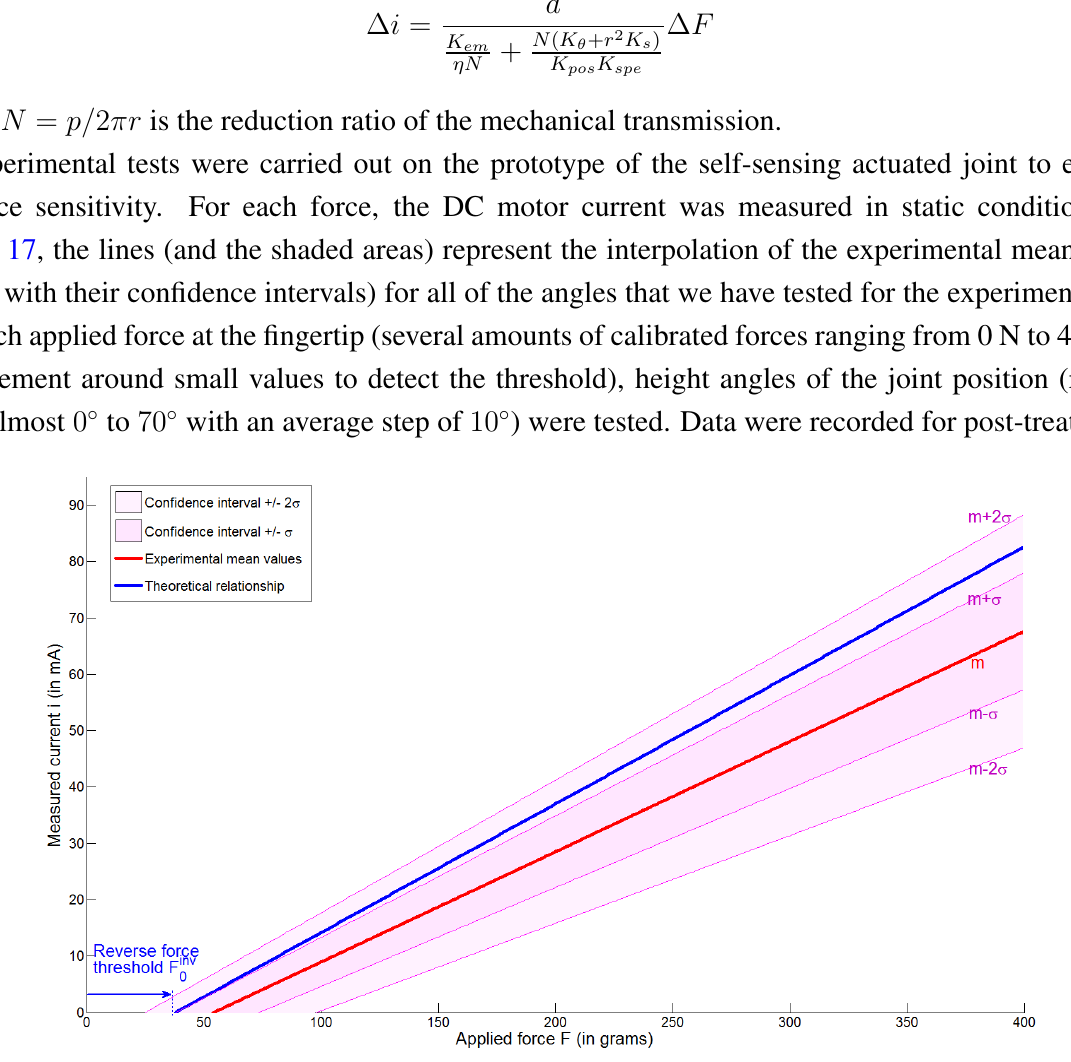
Figure 17. Experimental characterization of the self-sensing capability of the actuated joint (interpolated experimental mean values m along with its confidence intervals defined by its standard deviation σ for all of the angles ranging from 0 ◦ to 70 ◦ with an average step of 10 ◦